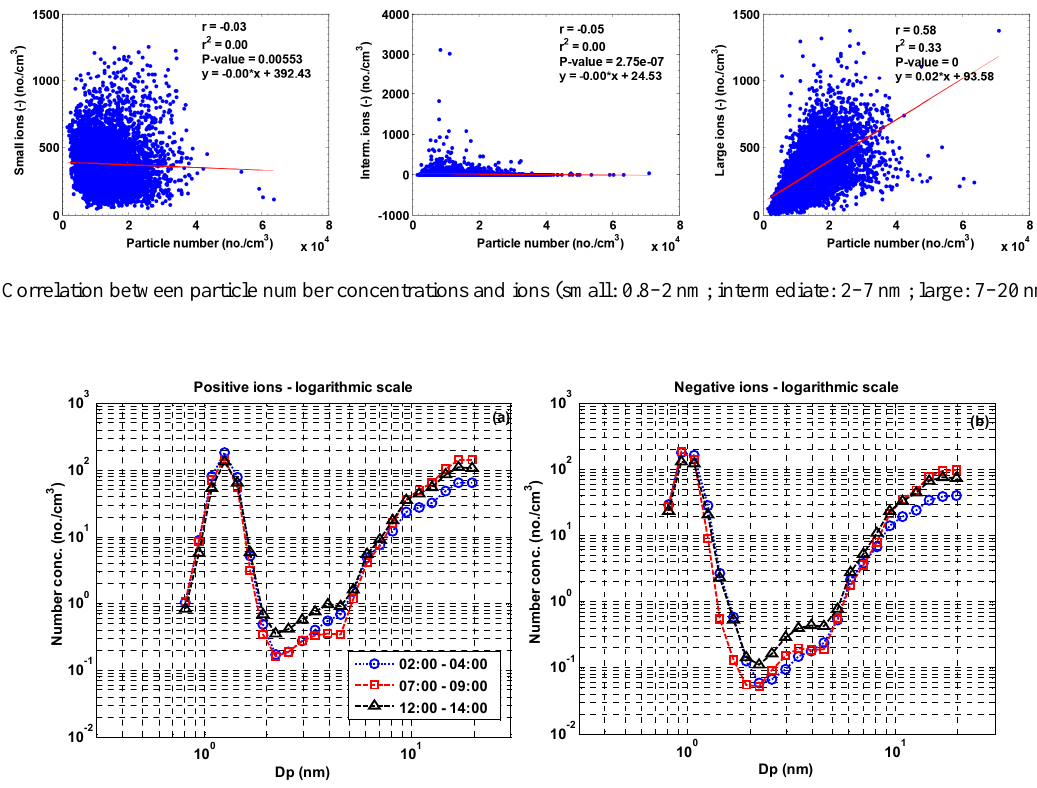
Figure A2. Median size distribution of ion on workdays: early morning (02:00–04:00), rush hours (07:00–09:00) and noon